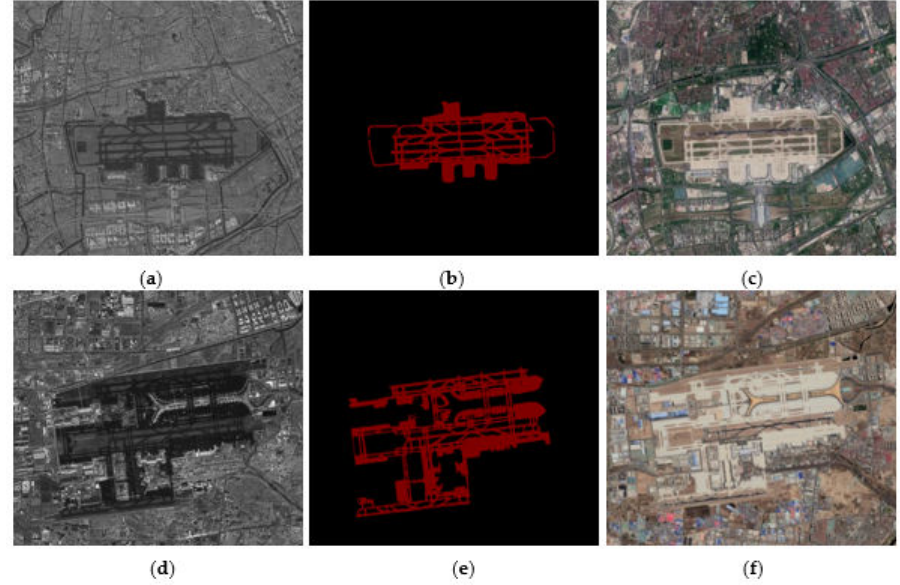
Figure 8. Airport images and corresponding ground truth. ( a – c ) denote the SAR image, ground truth, and the corresponding optical remote sensing image for Hongqiao Airport of China. ( d – f ) are the SAR image, ground truth, and optical remote sensing image for Capital